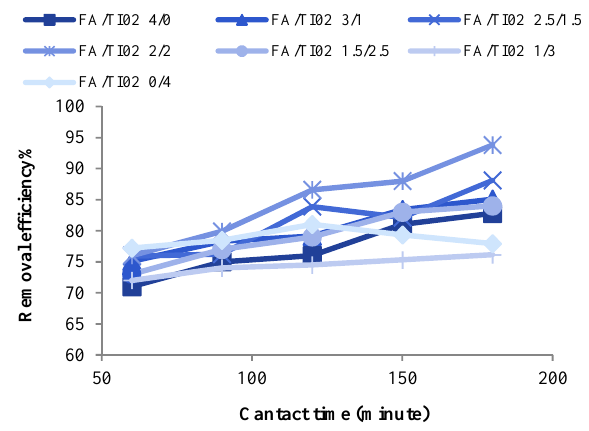
Figure 5. Effect of different FA:TiO removal efficiency [cyanide: 30 mg/l, unadjusted